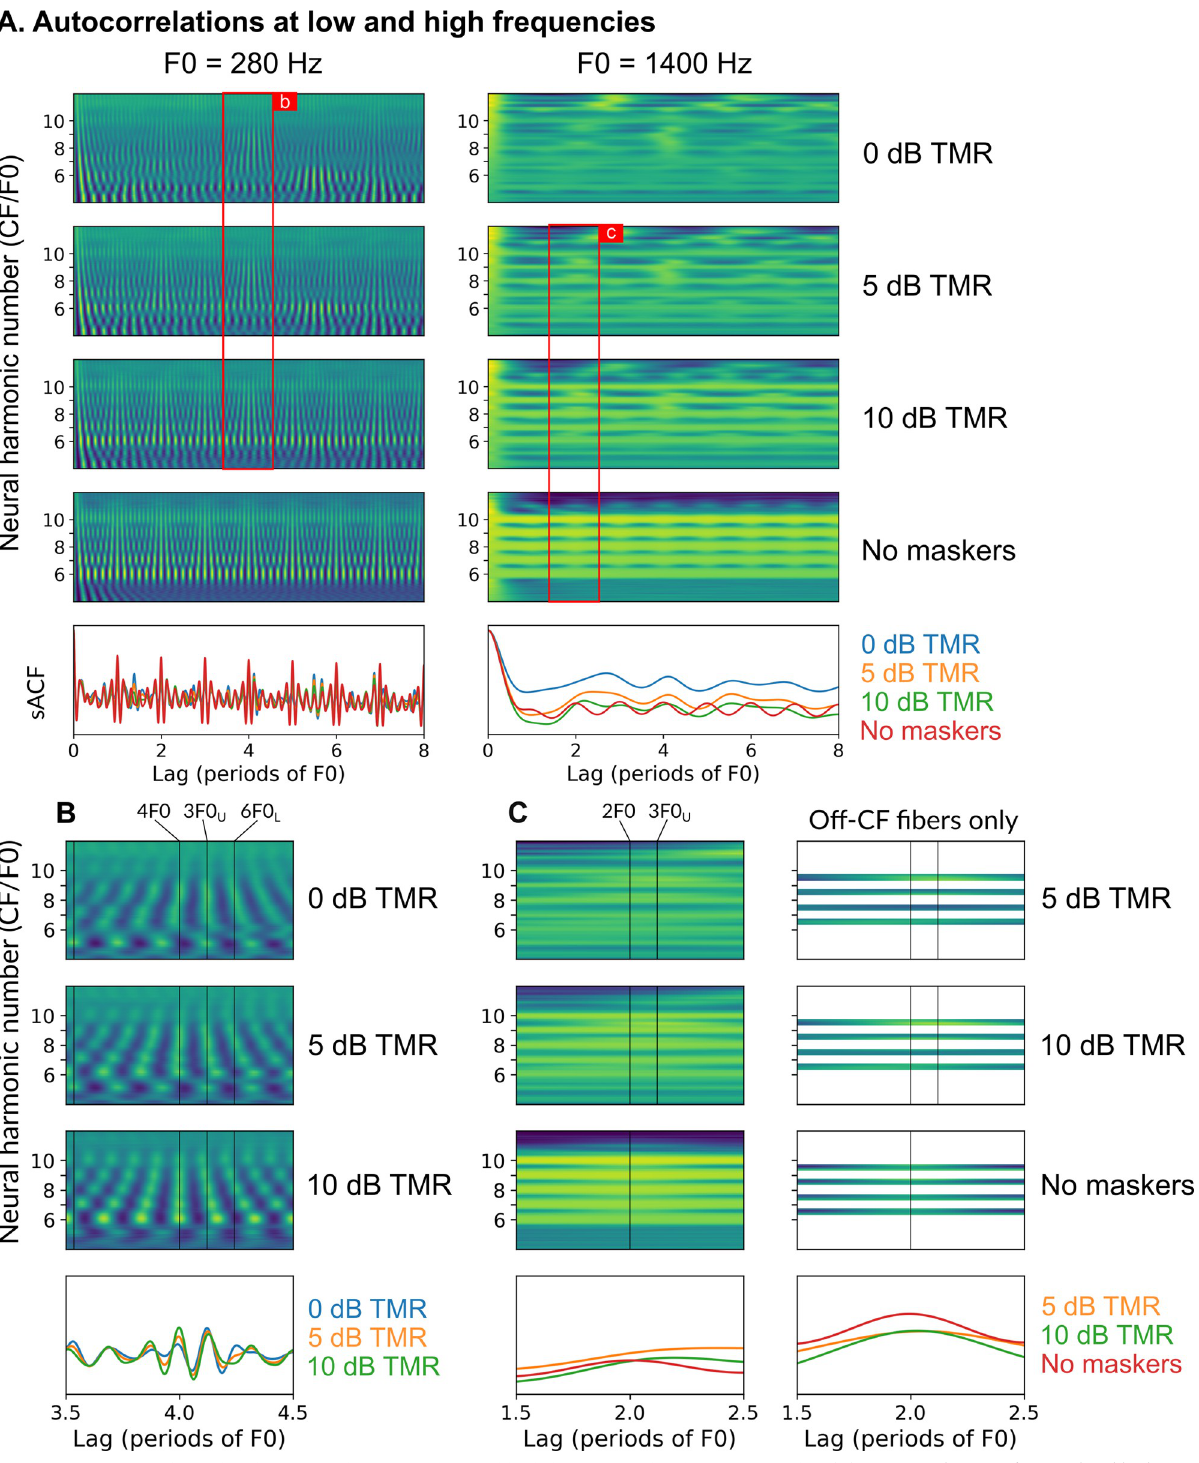
Fig 5. Comparison of simulated autocorrelograms at low and high frequencies for the DBL stimulus. (A) Autocorrelograms for simulated high- spontaneous-rate auditory-nerve-fiber responses [52] for the low-frequency DBL stimulus (left column) and the high-frequency DBL stimulus (right column). Here, one masker F0 was set to 5.5 ST below the target F0 while the other masker F0 was set to 6 ST above the target F0. The figure was constructed by fixing the target F0 and then varying the simulated CF (y-axis) linearly over a fixed range. For each CF, the instantaneous firing rate of the auditory-nerve model was computed and then the autocorrelation of that response was computed. Color (from purple/blue [low] to yellow/green